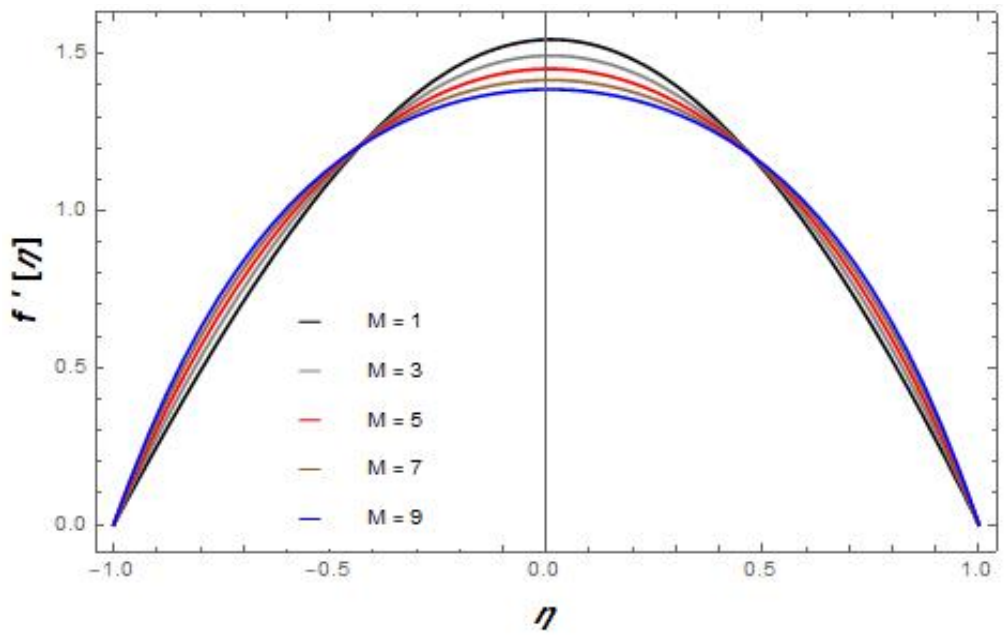
Figure 2. Effect of the magnetic parameter on velocity f (cid:48) .